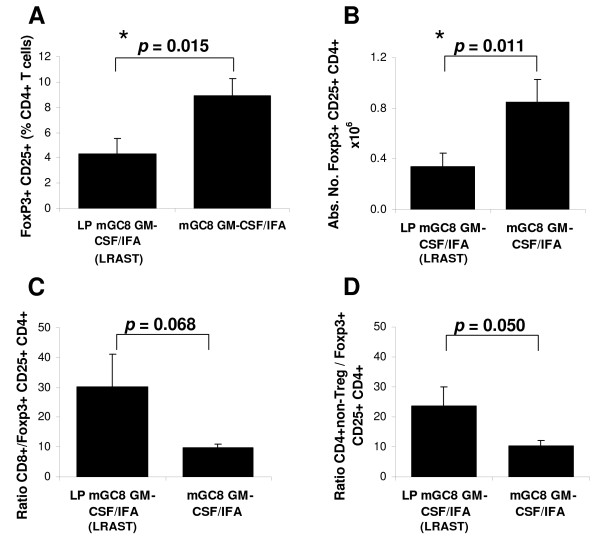
Effect of LRAST on the frequency of CD4+CD25+Foxp3+ cells. Mice were treated with LRAST or mGC8 GM-CSF/IFA in a therapeutic setting as described in Figure 4A. The mice were killed at day 9 after vaccination and splenocytes were analyzed by flow cytometry for the expression of Treg markers (FoxP3 and CD25). (A) Percentage of FoxP3+CD25+ cells calculated as a percentage of CD4+ T cells. (B) Absolute number of CD4+CD25+Foxp3+ cells calculated from initial splenocyte counts. (C) Ratio of CD8+ T cells to CD4+CD25+Foxp3+ (Tregs) and (D) Ratio of CD4+ non-Tregs to Tregs. (LRAST, n = 4; mGC8 GM-CSF/IFA, n = 2). Means and SE are indicated.